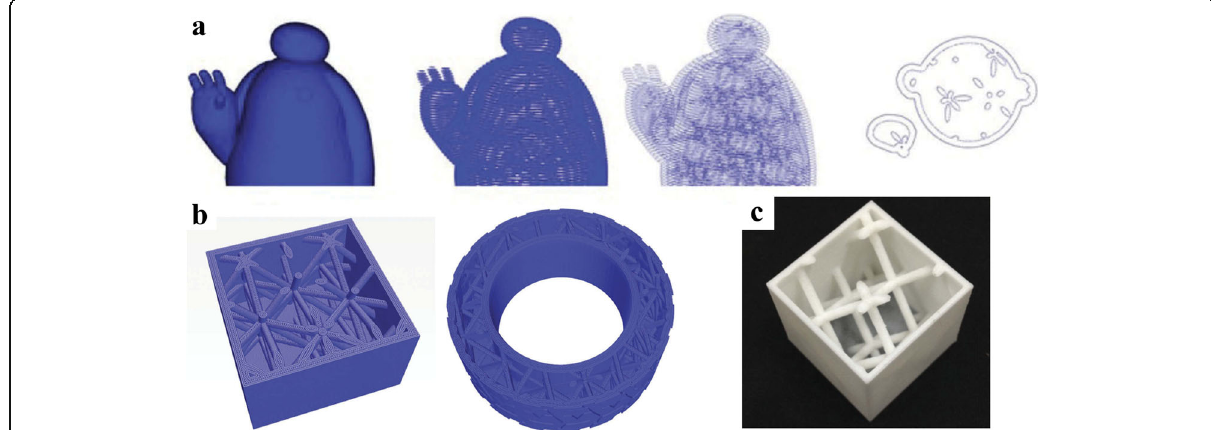
Fig. 10 Lightweight structure design based on LDNIs: a Generated infill paths for 3D printing lightweight structures. b Infill structures. c Manufacturing result